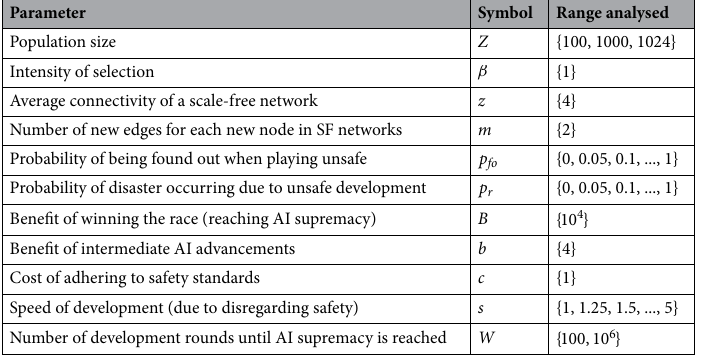
Table 1. Model parameters and parameter space